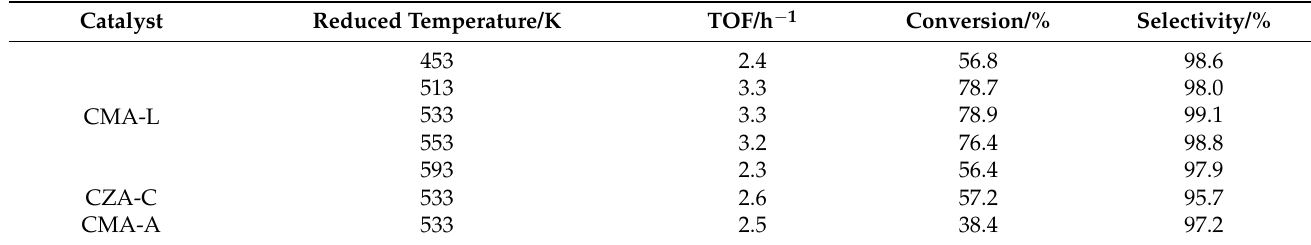
Table 3. Results of CHA hydrogenation performance over CMA-L.